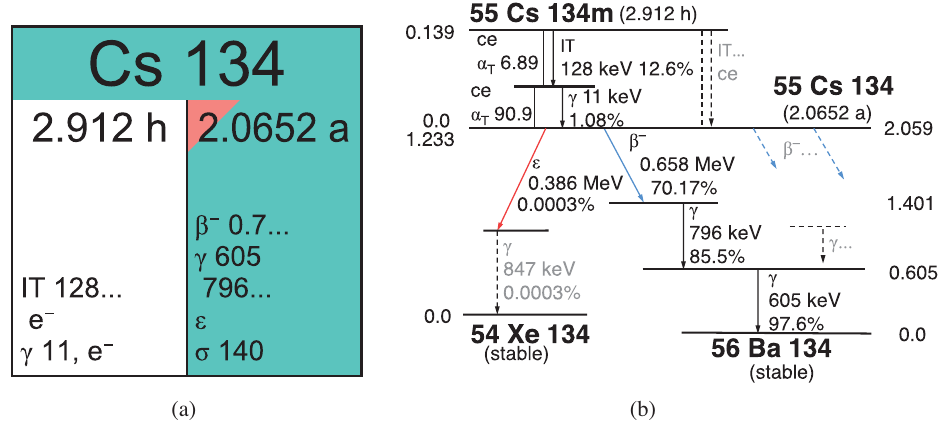
Fig. 4. Nuclide box (a) and the reduced decay scheme (b) for Cs 134 and